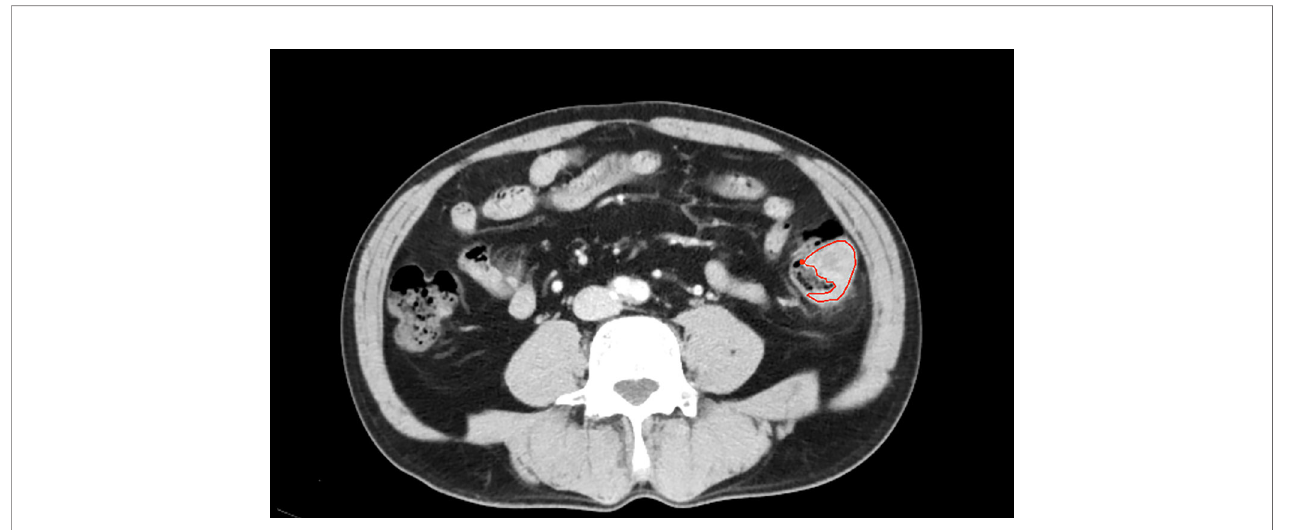
FIGURE 2 | One patient with descending coloncancer, male, 52years old. The area inside the red line represents the ROI for the